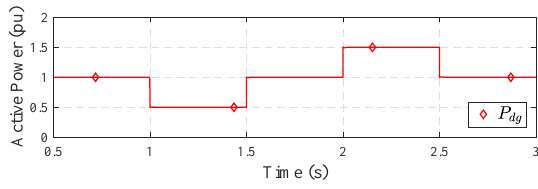
Figure 2. DG output power with ± 50% variance.